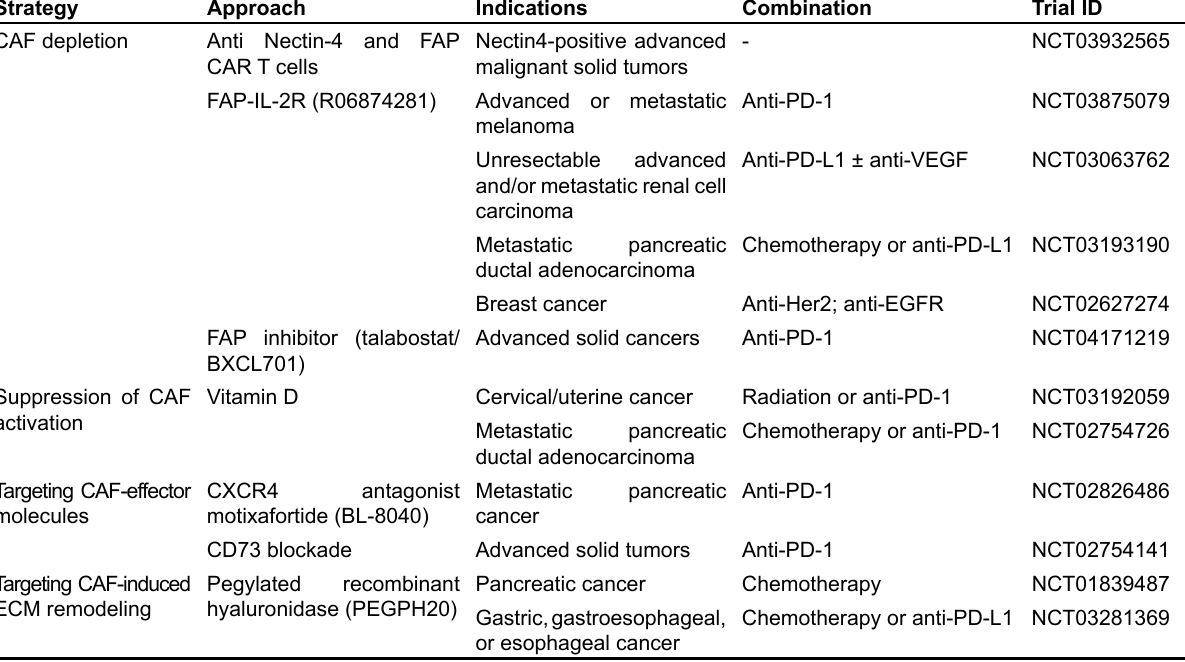
Figure 3. Schematic representation of the current main strategies to target CAFs. Several strategies are being explored in preclinical and/or clinical studies to target CAF-associated immunosuppression such as depletion of CAFs, restoration of their quiescent phenotype, targeting of CAFs-effector molecules or targeting of CAFs-associated ECM remodeling. FAK: focal adhesion kinase; FGFR: FGF receptor Table 1. Examples of clinical trials targeting